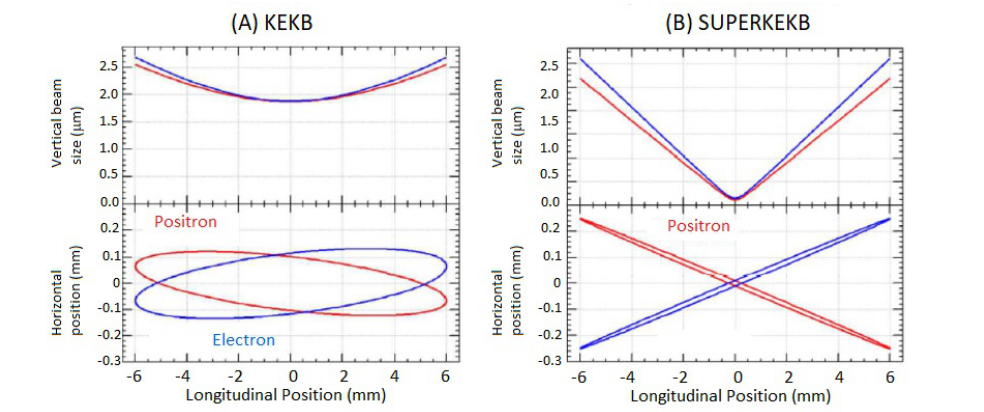
Figure 2. The vertical beam size at collision for both beams at KEKB ( a ) and SuperKEKB ( b ).